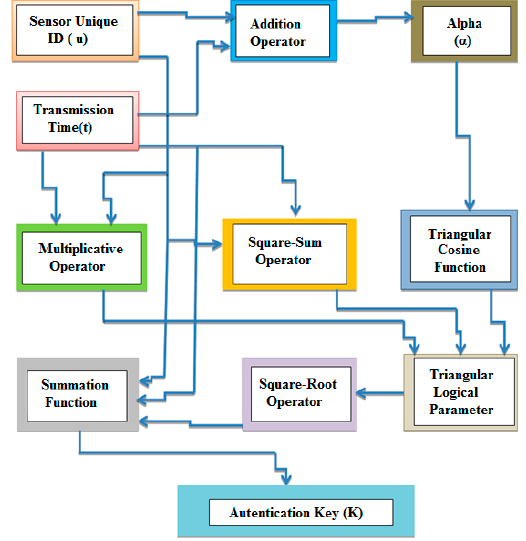
Figure 4. Key generation mechanism for proposed TBSA.